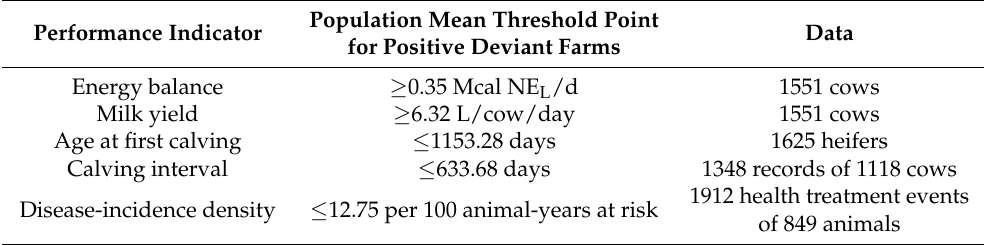
Table 1. A summary of threshold points for each performance-indicator variable set for identifying positive deviant farms in 794 sample